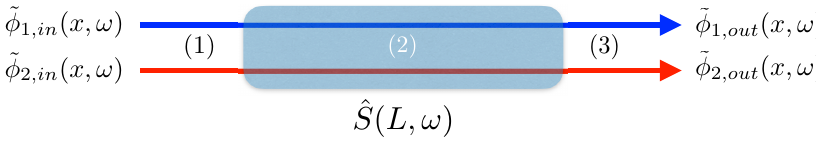
Figure 1: Schematic view of a two integer quantum Hall channels system (filling factor ν = 2). According to the chirality one can easily identify the incoming region ( 1 ) , the interacting re- gion ( 2 ) (shaded area) and the outgoing region ( 3 ) . In regions ( 1 ) and ( 3 ) the dynamics of the bosonic fields is well described in terms of free equations of motion, while the outgoing fields are connected to the incoming ones through the edge-magnetoplasmon scattering ma- trix ˆ S ( L , ω ) which encodes the information of the inter-channel interaction (assumed as strong and short ranged in the main